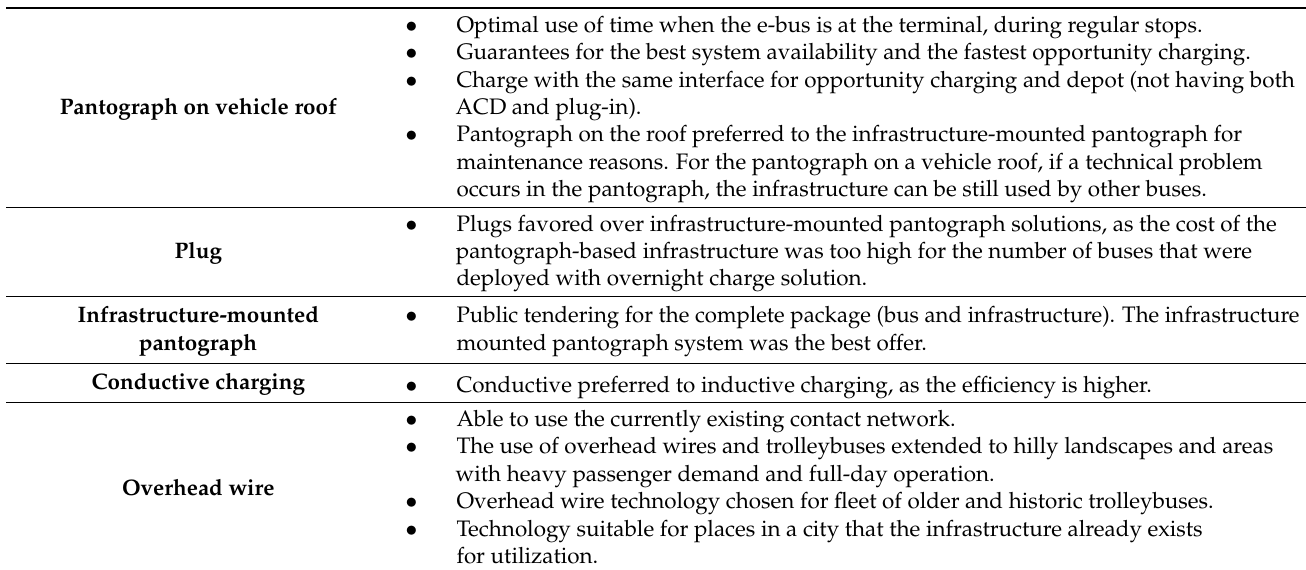
Figure 1. Types of charging technologies that the end users’ organizations owned or used. Table 5. Reasons for organizations to choose a specific charging